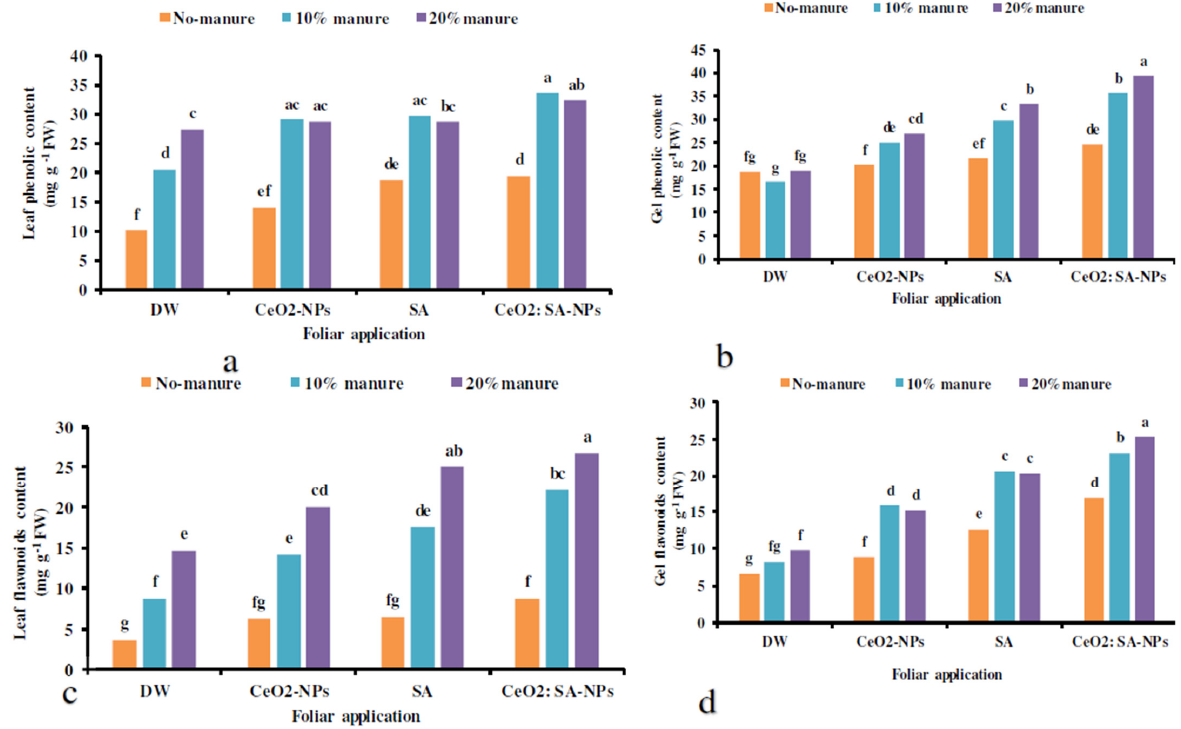
Figure 4. The interaction effects of soil-based animal manure application (0%, 10%, and 20% v / v ) and foliar use of distilled water (DW), salicylic acid (SA), cerium oxide nanoparticles (CeO 2 -nanoparticles), and cerium oxide salicylic acid nanoparticles (CeO 2 : SA-nanoparticles) on the phenolics content of the leaves ( a ) and gel ( b ) as well as the flavonoids content of the leaf ( c ) and gel ( d ) of Aloe vera L. plants. Significant differences among treatments are indicated by the different Latin letters on bars.